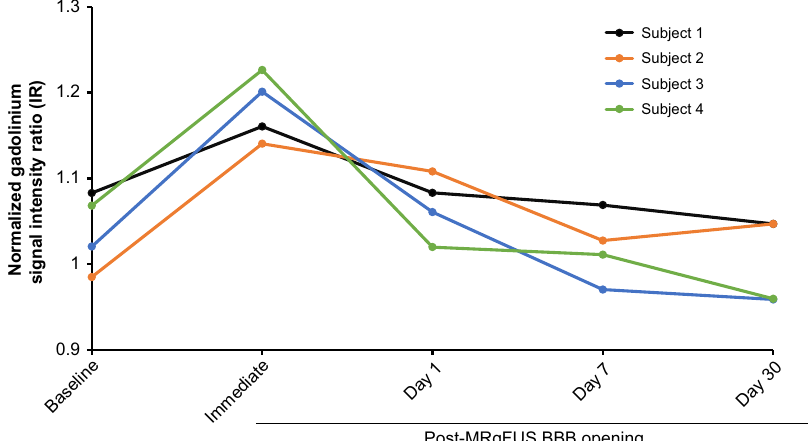
Fig. 4 Baseline and post-procedure gadolinium signal intensity ratio (IR) within the sonicated region on T1-weighted imaging. IRs were normalized to the contralateral, unsonicated mirrored region. Increased IRs were seen immediately after blood – brain barrier opening and returned to baseline within 24 h, indicating reversible BBB permeability. Raw data are provided in the Source Data fi le